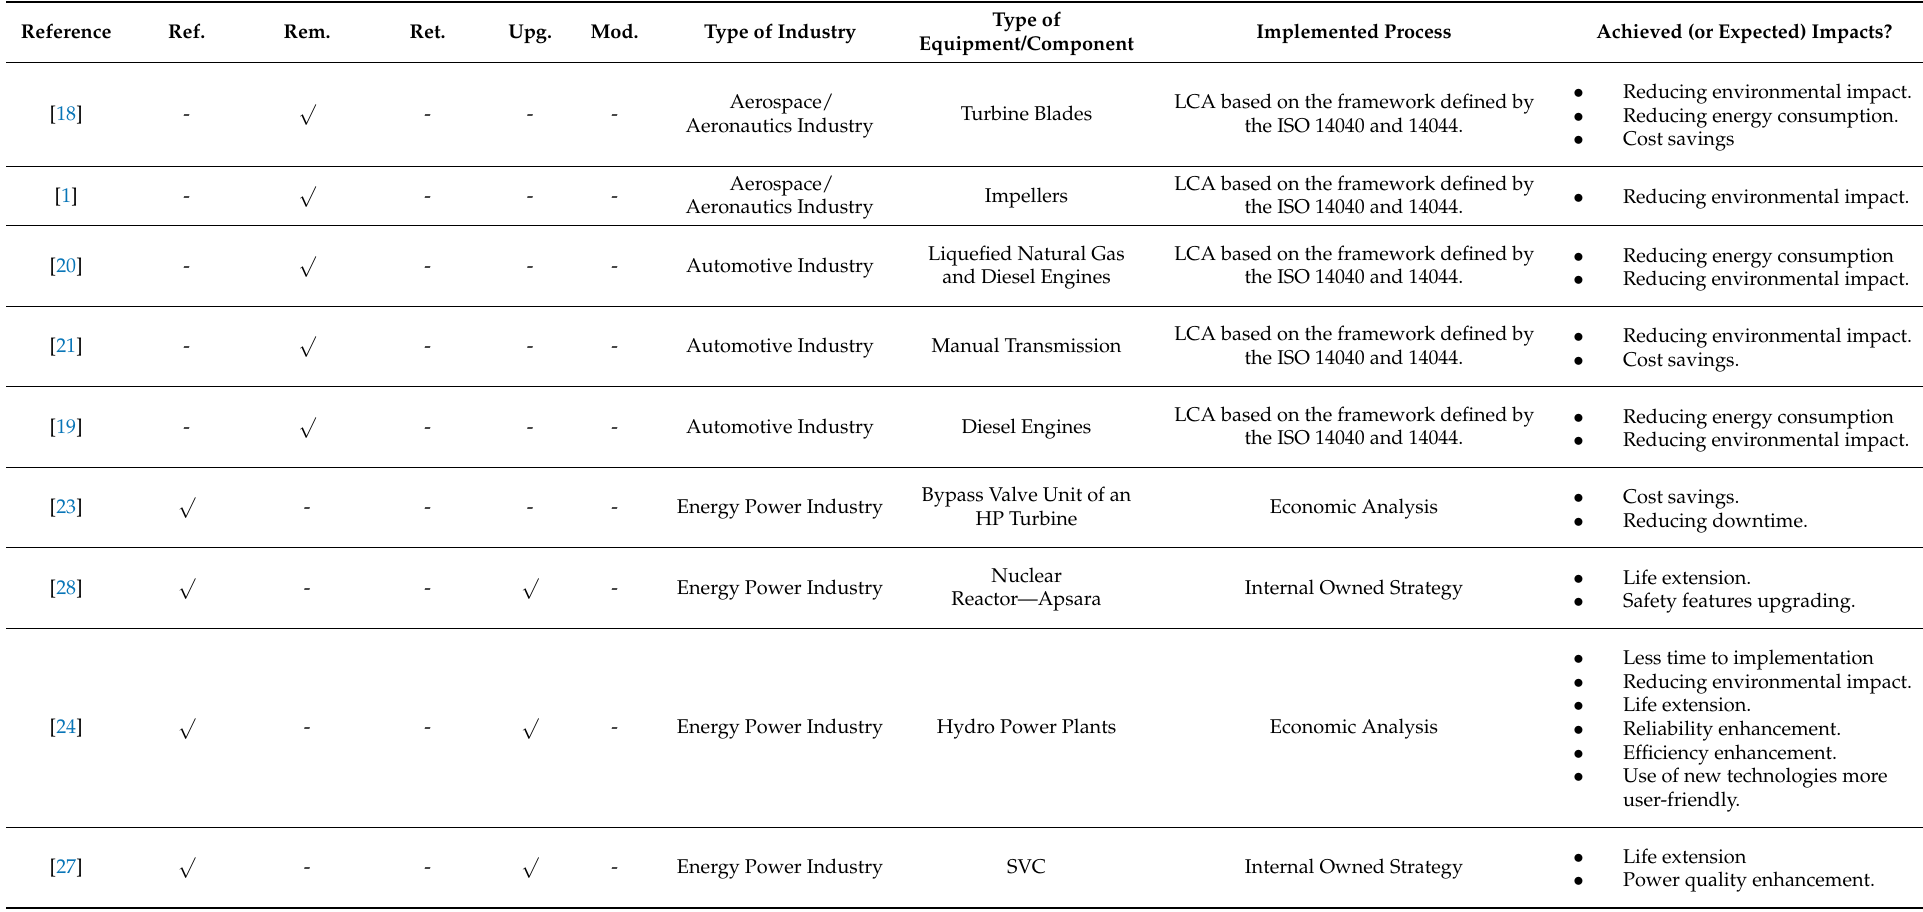
Table 4. Publications and systematized information about remanufacturing and